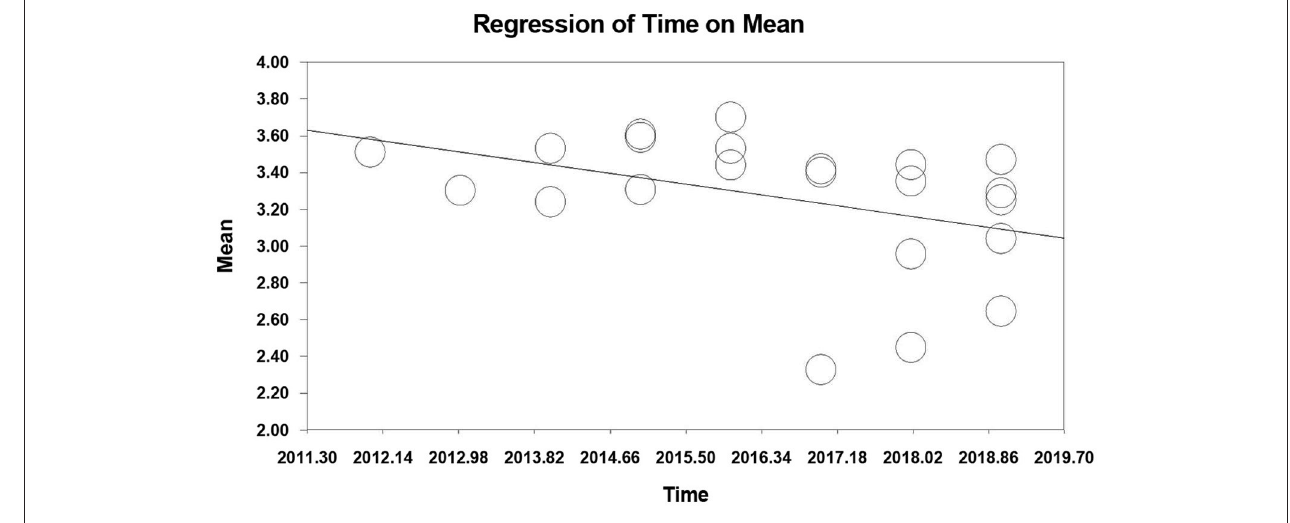
FIGURE 2 | Meta-regression of time on resilience.